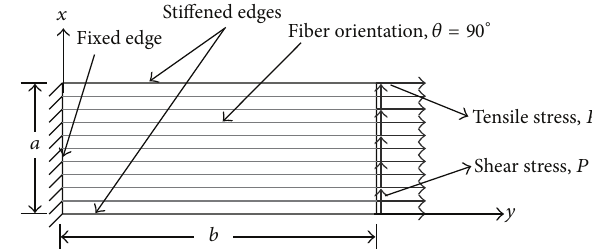
Figure 1: Model of an orthotropic composite panel subjected to a combined loading (uniform tension and